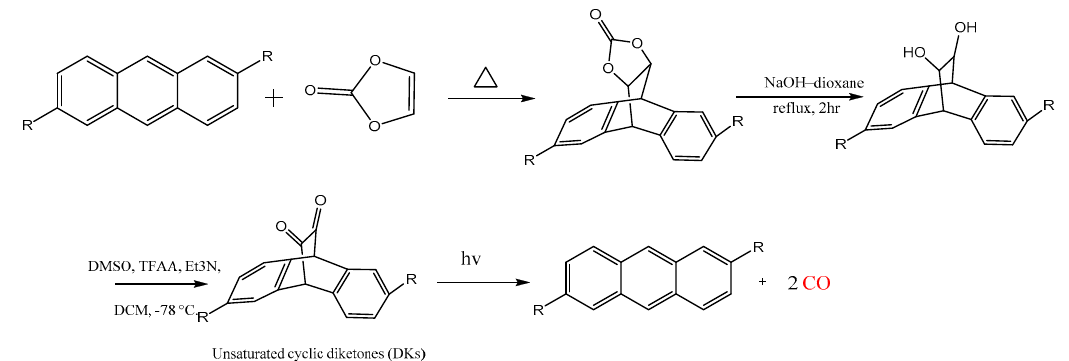
Figure 8. Synthesis route of unsaturated α‐ diketones ( α‐ DKs) has been activated by photons energy.